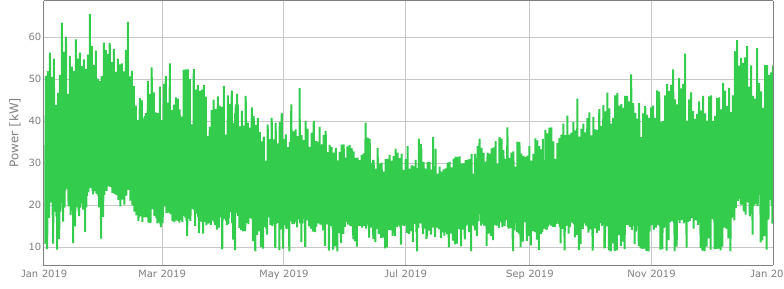
Figure 5. Estimated power consumption of LV users of